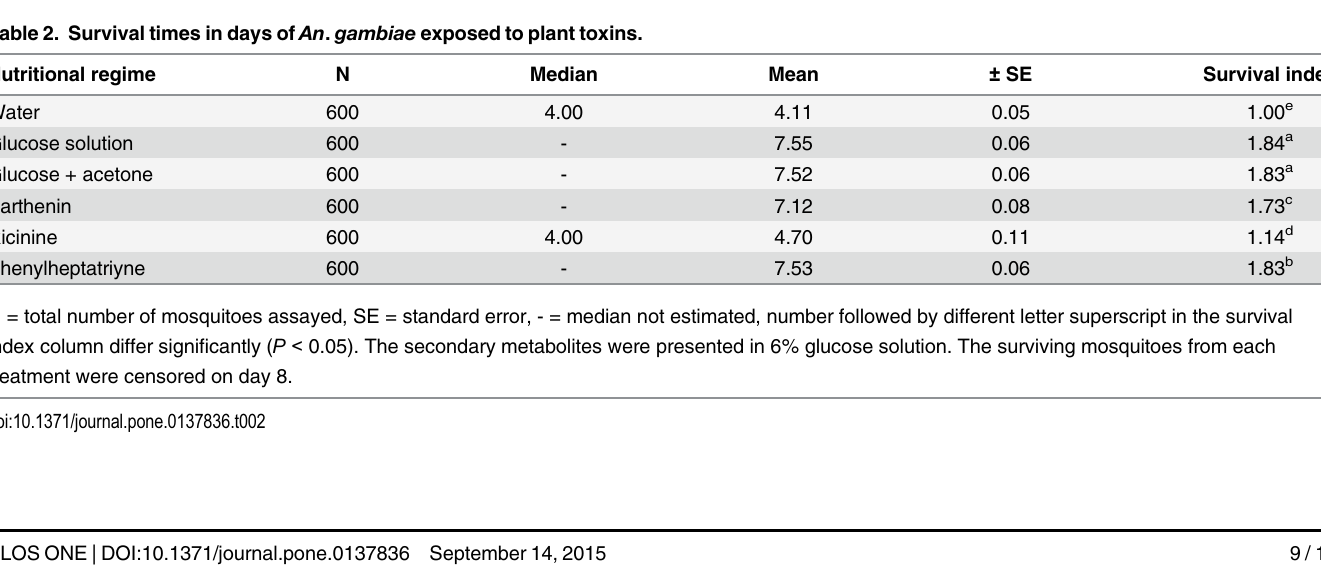
Table 2. Survival times in days of An . gambiae exposed to plant toxins. Nutritional regime